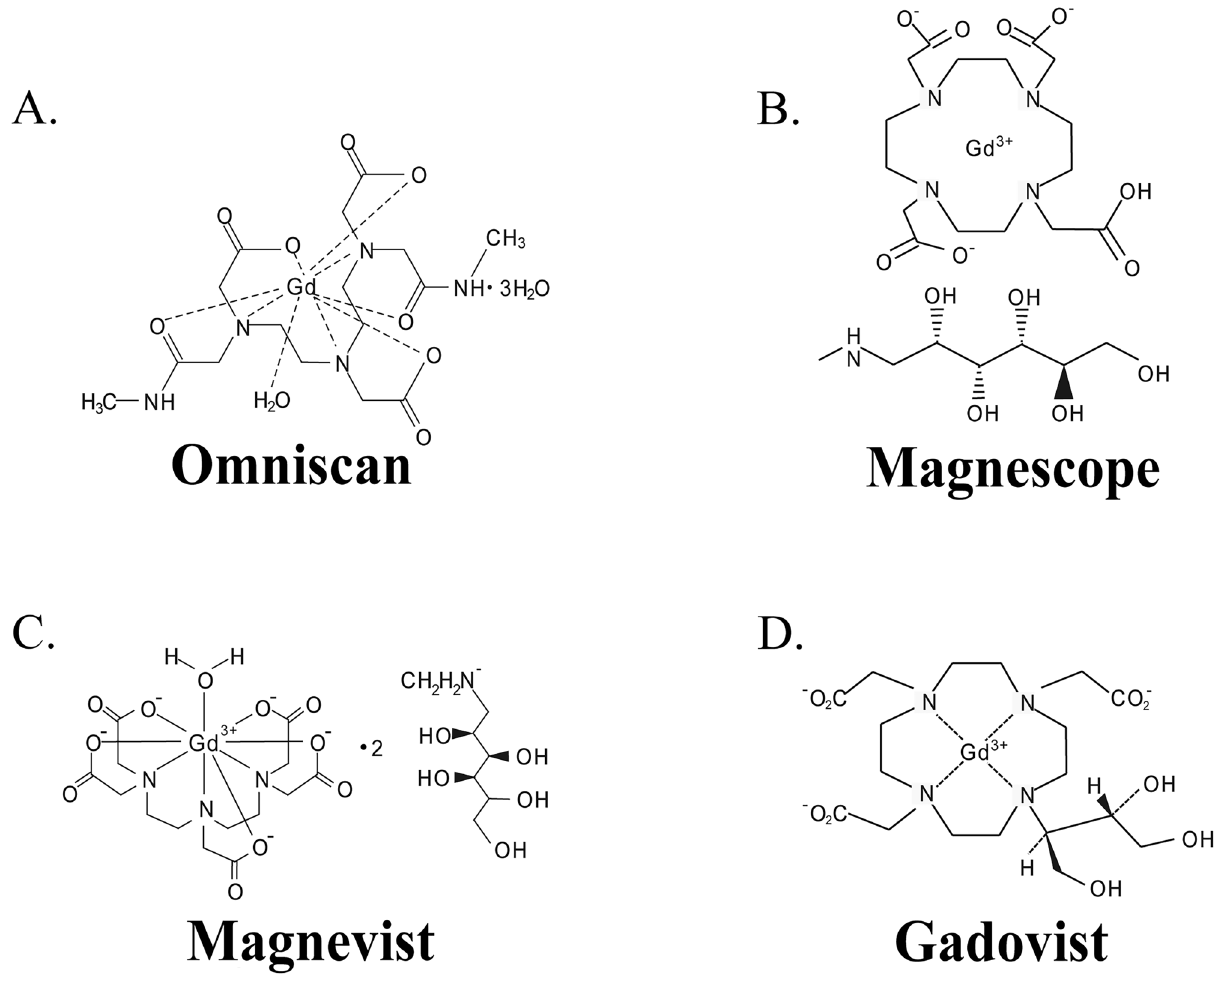
Figure 1. Chemicals structures of